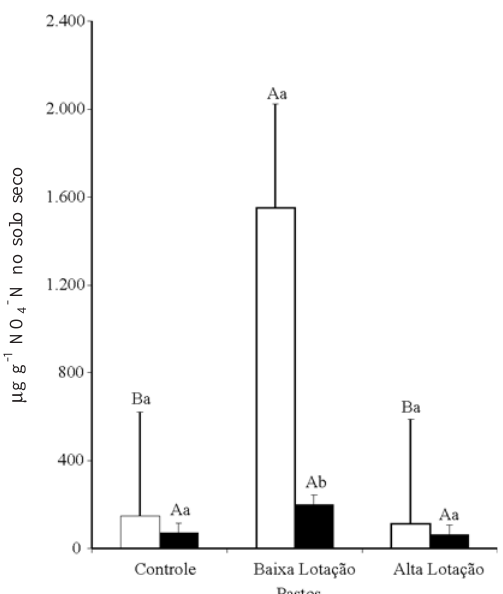
Figura 4. Atividade ureolítica encontrada nas camadas de 0–10 ( ) e 10–20 cm ( ) do solo pastejado por ovinos. Médias seguidas de mesma letra, minúscula (profundidade) e maiúscula (pastos), dentro de cada variável, não diferem entre si pelo teste de Tukey a 5 %. As barras representam o erro-padrão (n = 15).